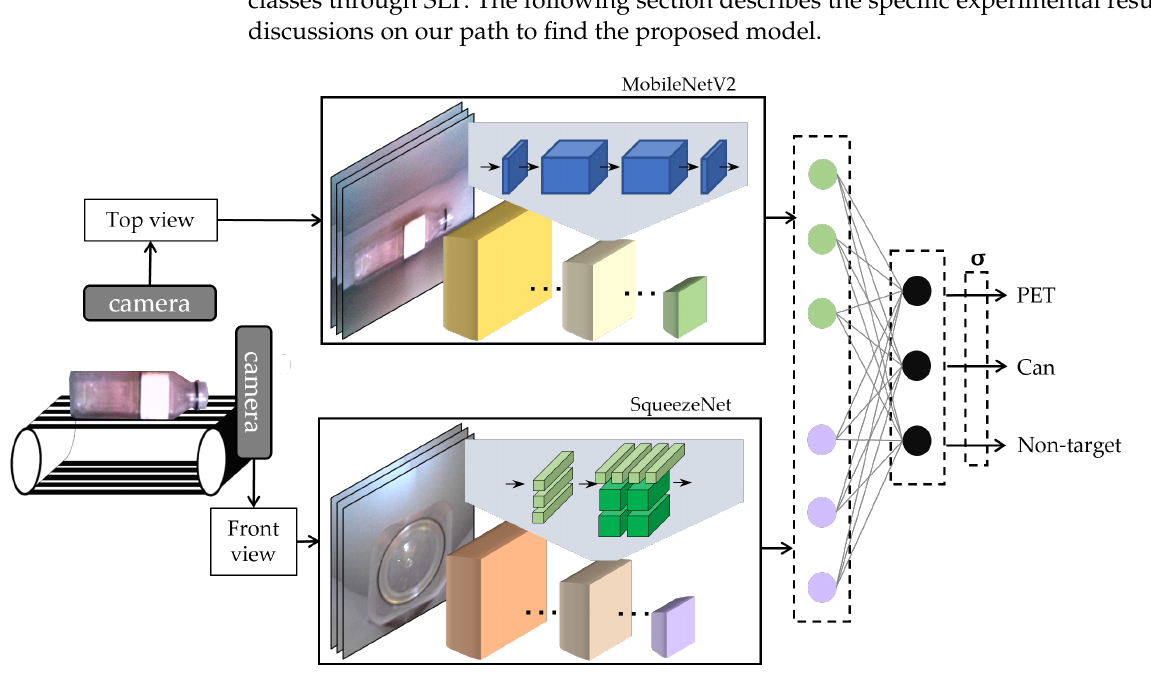
Figure 8. Framework of the proposed CNN ensemble